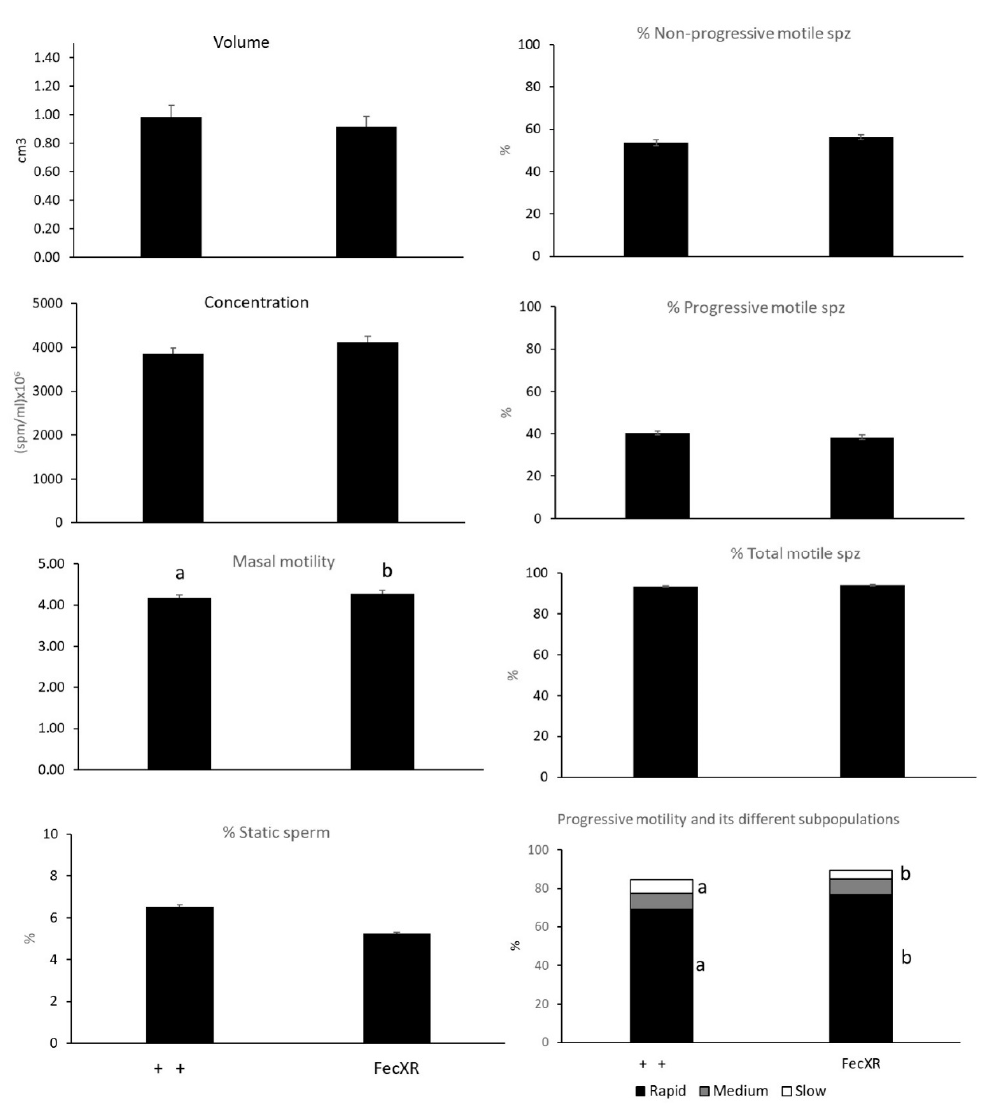
Figure 1. Seminal traits (mean ± S.E.M.) of Rasa Aragonesa rams of the wild genotype (+ +; n = 5) or those carrying the FecXR allele of the BMP15 gene ( n = 10) (a,b indicate p < 0.05) (spz: spermatozoon). Values calculated from semen samples collected twice a week for one year.